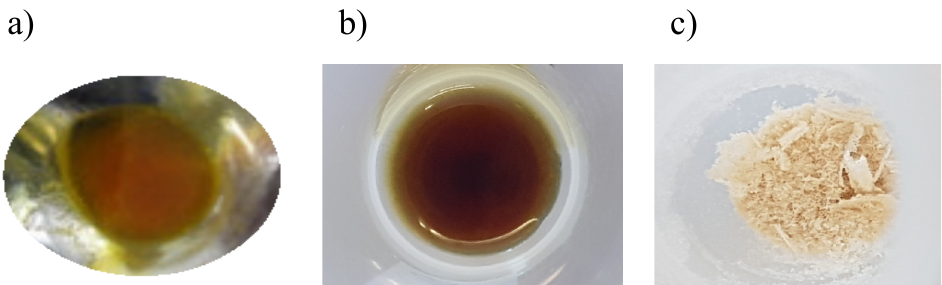
Figure 3. Macroscopic appearance of ( a ) lipopeptide, ( b ) rhamnolipid and ( c ) glycolipopeptide microbial